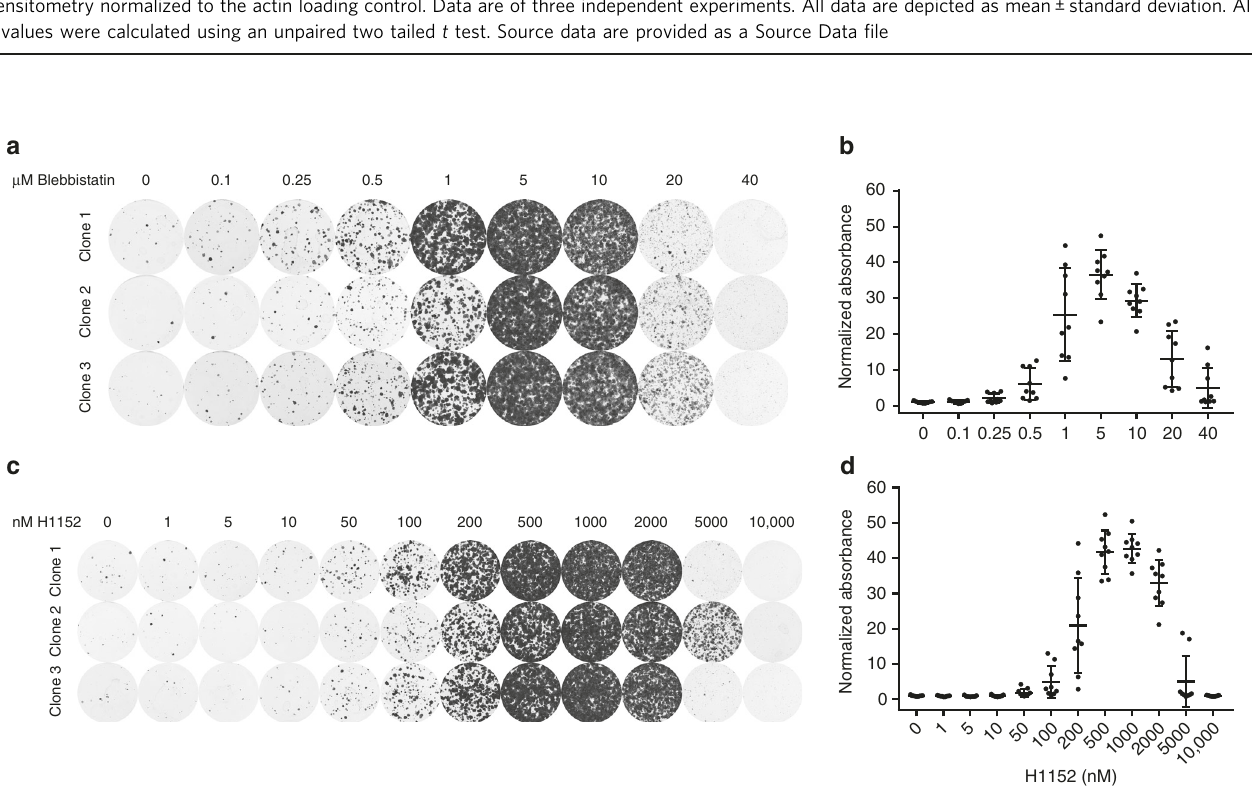
Fig. 4 Balanced actomyosin contractility is essential for survival. a , b Representative images ( a ) and quanti fi cation ( b ) of clonogenic assays with Wcre; Cdh1 F/F ;mTmG MMECs cultured with different concentrations of blebbistatin. Data are of three independent experiments with three clones per experiment. c , d Representative images ( c ) and quanti fi cation ( d ) of clonogenic assays with Wcre;Cdh1 F/F ;mTmG MMECs cultured with different concentrations of H1152. Data are of three independent experiments with three clones per experiment. All data are depicted as mean ± standard deviation. Source data are provided as a Source Data fi